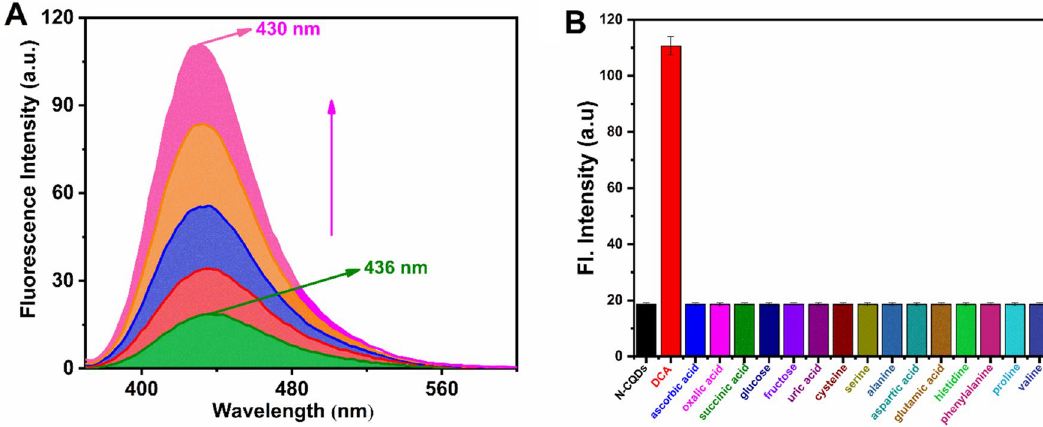
Figure 3. ( A ) Fluorescence emission spectra of the N-CQDs/Co complex in the presence of different concentration of DCA. ( B ) competitive fluorescence spectra of N-CQDs/Co complex with different acids and amino acids at 430 nm (λex= 350 nm). All experiments were performed in PBS buffer